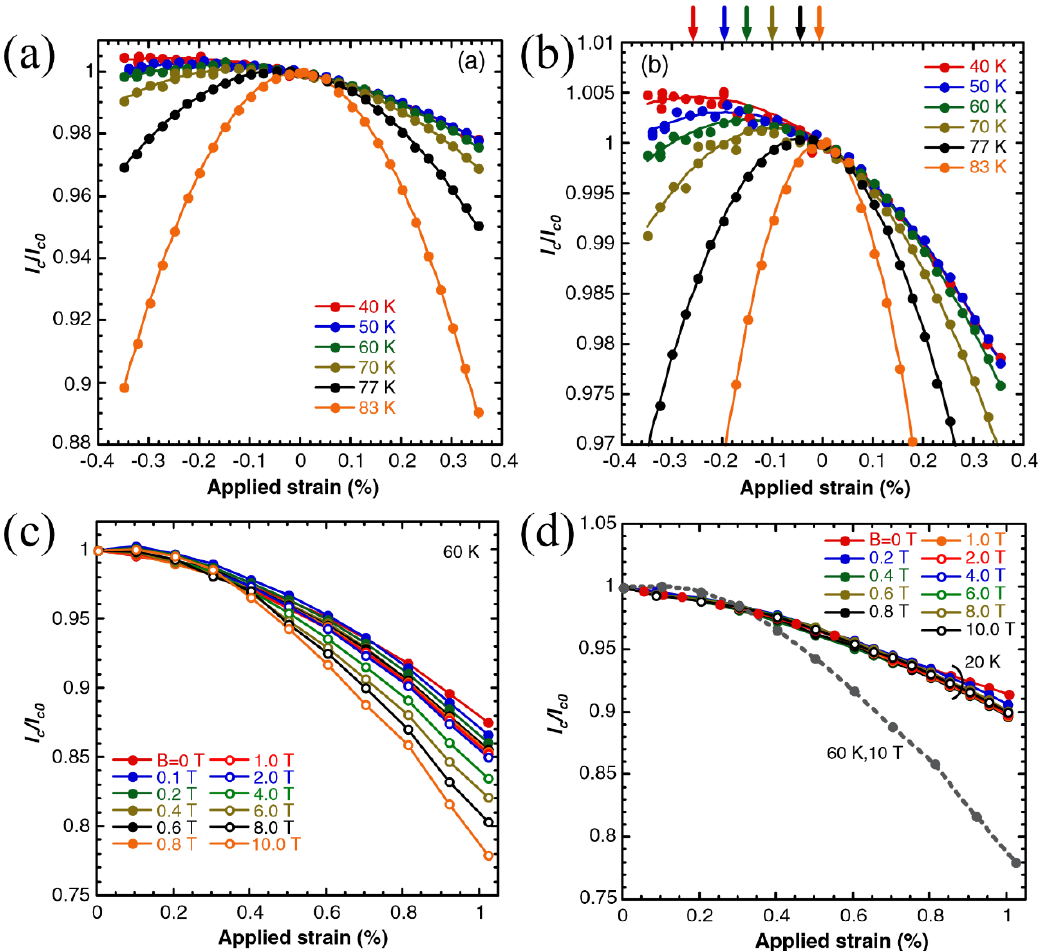
Figure 9. T vs. normalized I c in self-field for 0.1 µ m thick YBCO layers. The whole data ( a ) and corresponding enlarged view ( b ) around the peak are presented. B vs. normalized I c at 60 K ( c ) and 20 K ( d ). Reprinted with permission from Ref. [13]. Copyright 2010, IOP Publishing Ltd.